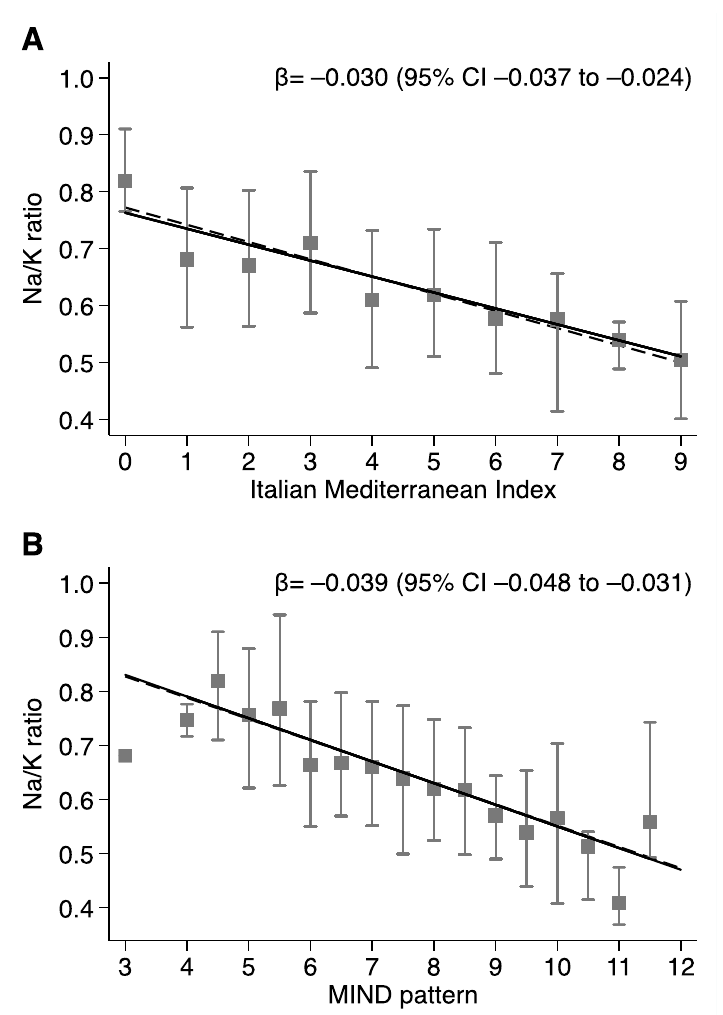
Figure 2. Linear regression between sodium-to-potassium (Na/K) ratio and Italian Mediterranean Index-IMI ( A ) or MIND pattern ( B ). Squares and spikes indicate median and interquartile range, respectively. Solid and dashed lines indicate crude and adjusted linear fitting, respectively.